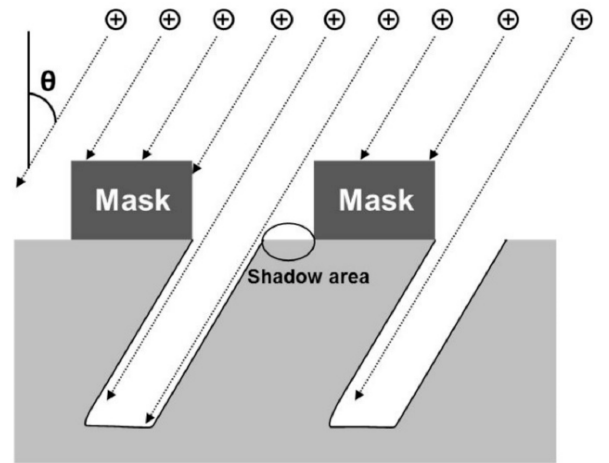
Figure 6. Illustration of the shadowing effect due to the ions incident on the substrate in the oblique direction from the surface